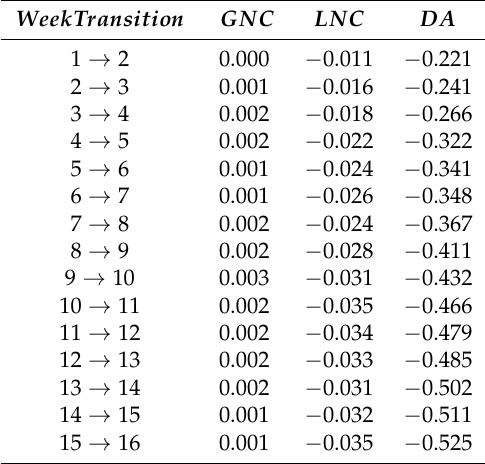
Table 2. MH sampling and dynamic analysis.